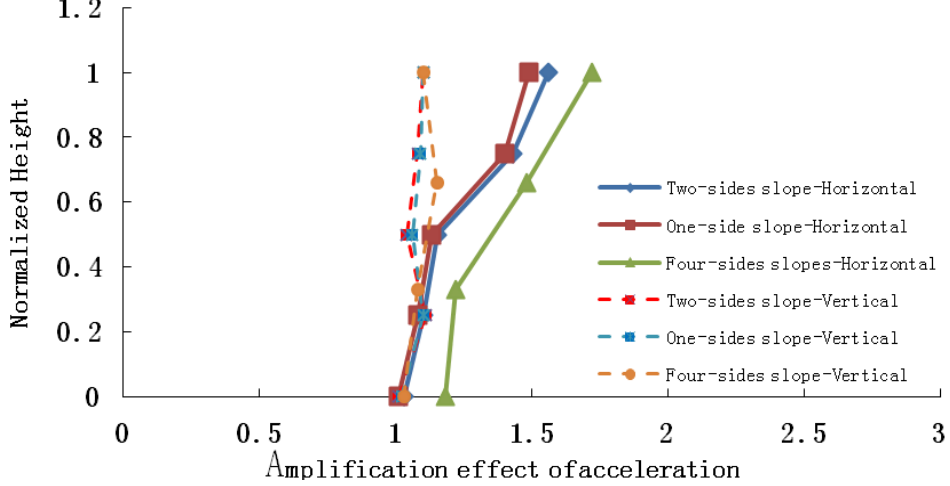
Figure 13. Horizontal and vertical acceleration amplifications when the input is PGA = 0.4